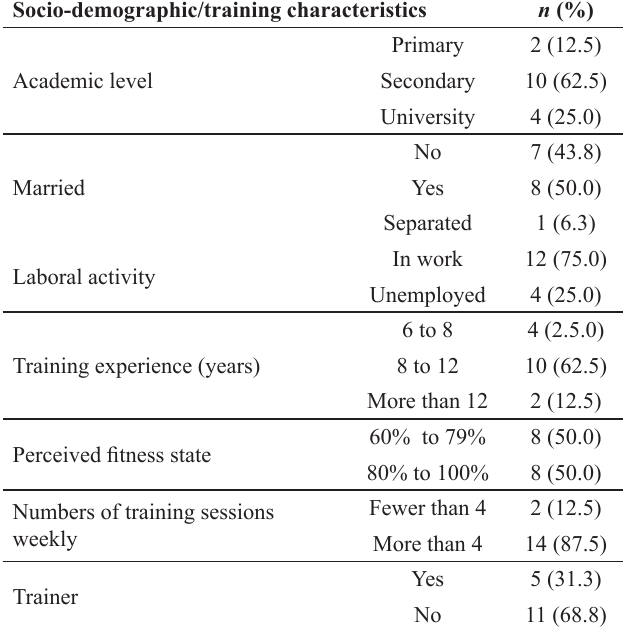
Table 1. Socio-demographic characteristics and training background of the participants ( n ,